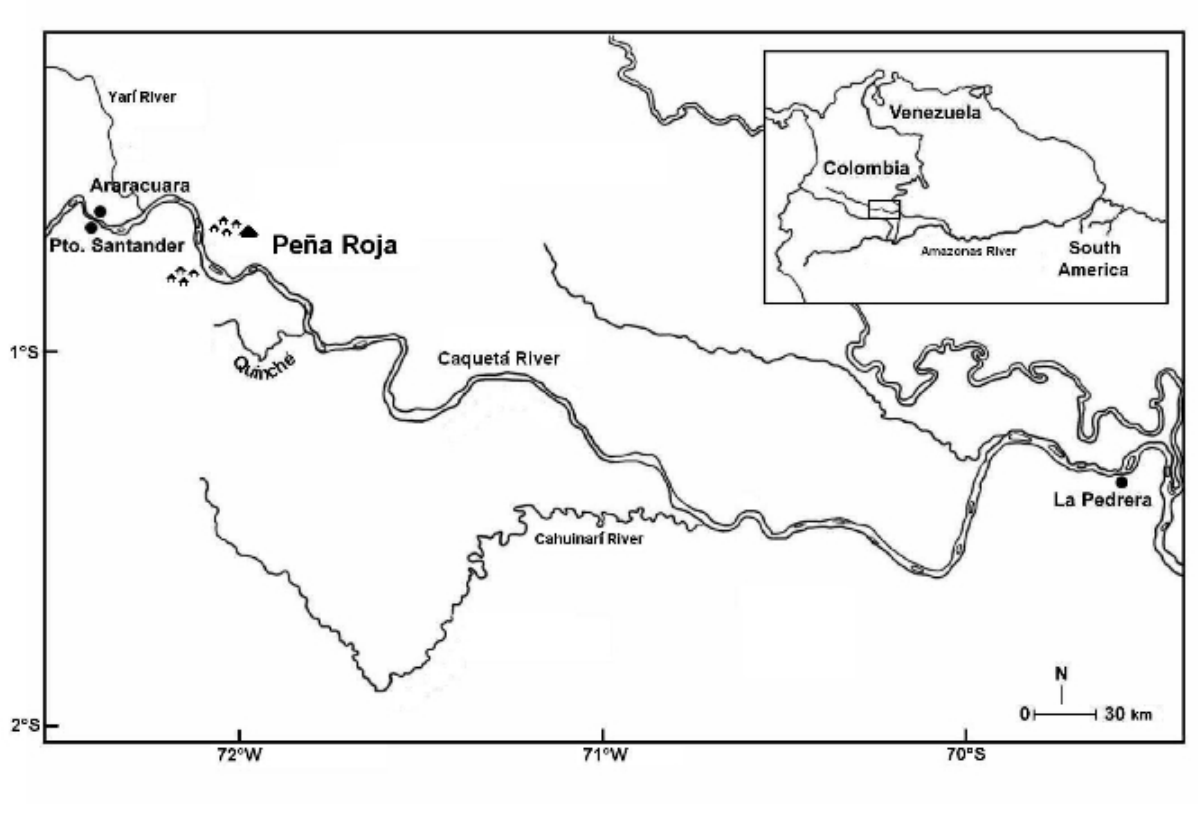
Fig. 1. Middle and Lower Caquetá River region, State of Amazonas, Colombia. (Map from: Duivenvoorden and Lips 1993). The Nonuya people are settled in Peña Roja, located at the western and eastern margin of the Caquetá